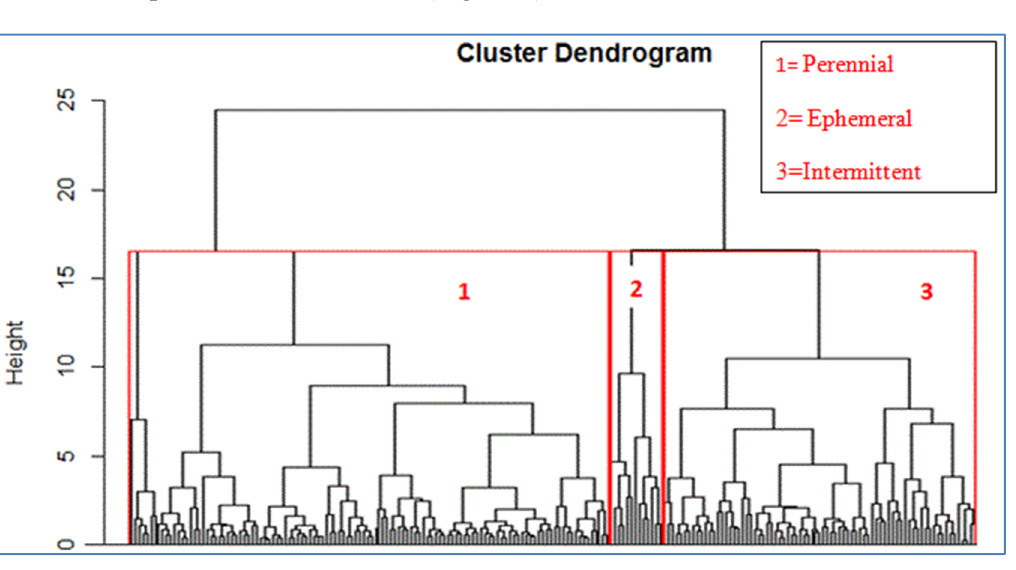
Figure 2. Cluster dendrogram of flow regime